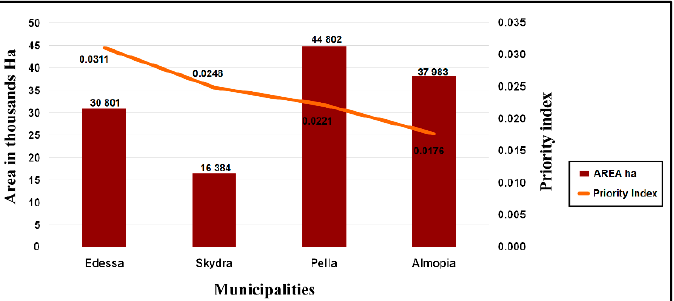
Figure 5. Values per municipality and Relative Priority Index (RPI A ) values.